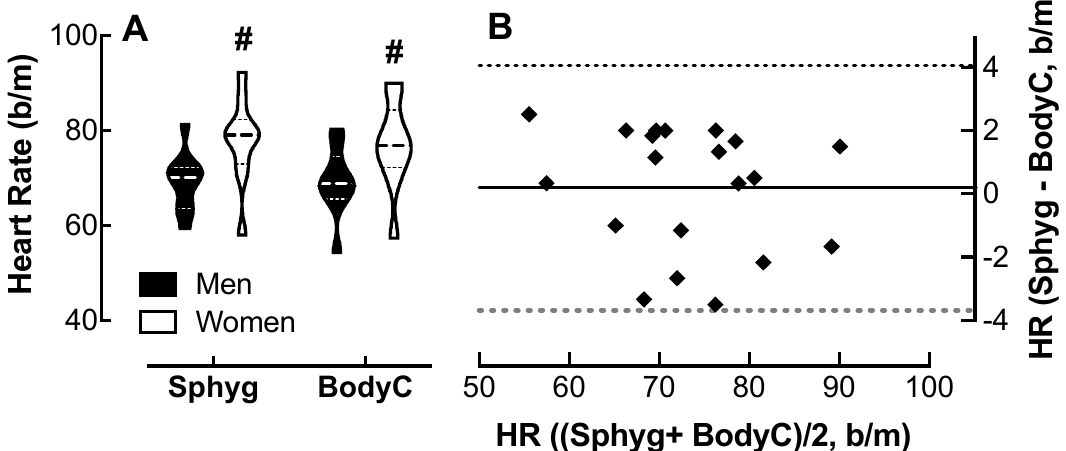
Figure 2. Comparison of heart rate (HR measured by the Body Cardio with SphygmoCor determinations. ( A ) Violin plot of HR measured by the Sphyg and BodyC in men and women; p < 0.01, male vs. female by two-way ANOVA; n = 10 / group. ( B ) Q-Q plot of HR determined by the Sphyg and BodyC. Each data point represents duplicate or triplicate measures in one study participant. HR, heart rate. The 95% CI was − 3.68 to 4.1 b / m for all participants; however, the CI was greater in the men compared to the women (Table 1).